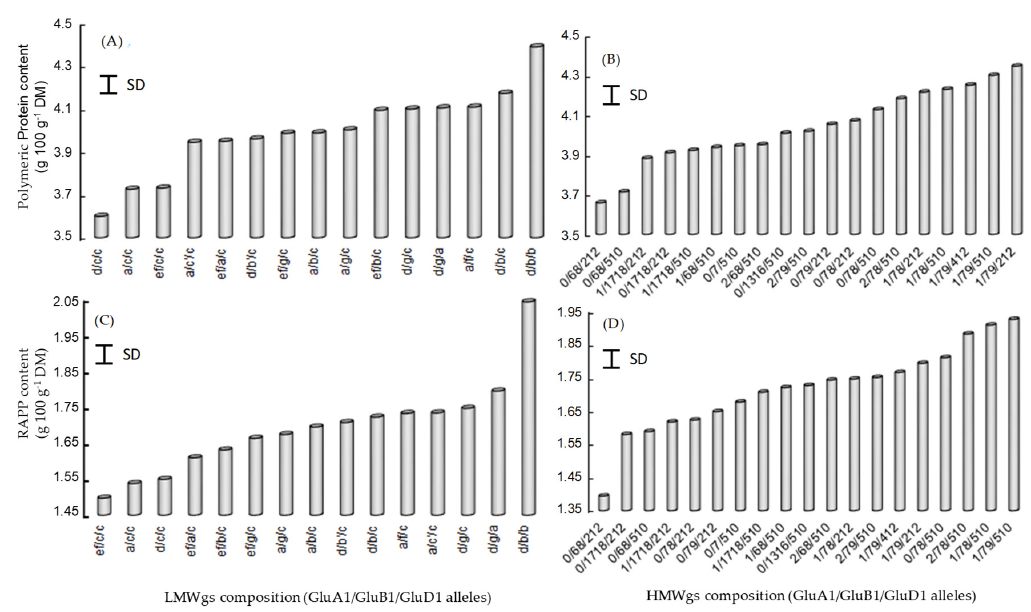
Figure 5. Relationship between ( A , C ) LMWgs composition or ( B , D ) HMWgs composition of polymeric protein (PP) and ( A , B ) their content or ( C , D ) the RAPP content (Molecular mass > 2 × 10 6 g mol − 1 ) in wheat grains. SD: Standard deviation. The GluA1 nul allele is noted 0. For example, cultivars having the following HMW-GS encoded at GluA1 , GluB1 and GluD1 nul, 7–8, 2–12, respectively are noted 0/78/212.